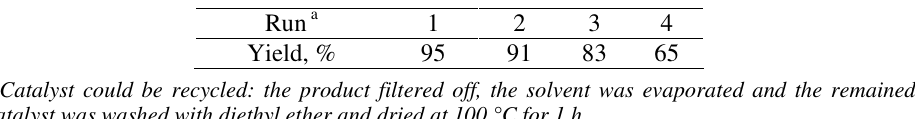
Table 4. Investigation of the feasibility of reusing Preyssler acid catalyst in synthesis of 1-benzyl-2,4,5-triphenyl-1 H -imidazole (4a) in